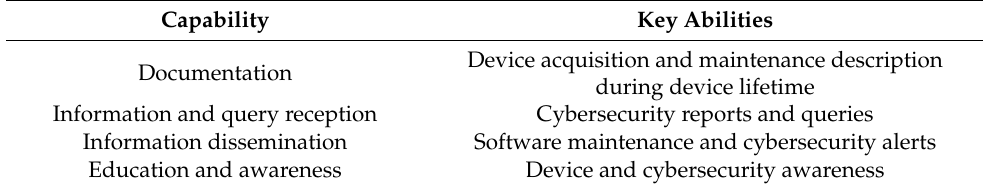
Table 3. Non-technical supporting capabilities for IoT providers. NIST-IR